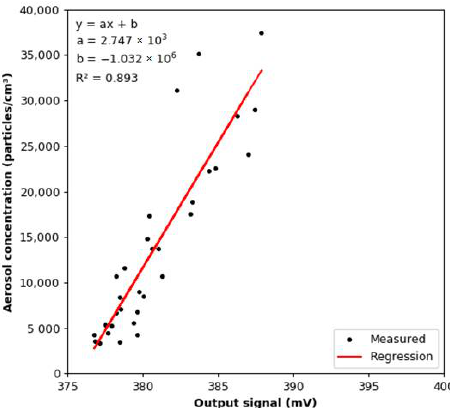
Figure 12. Readings from the aerosol detectors during the soot effect test: ( a ) total particle number concentrations measured by the MiniWRAS; ( b ) output signal from the smoke detector.